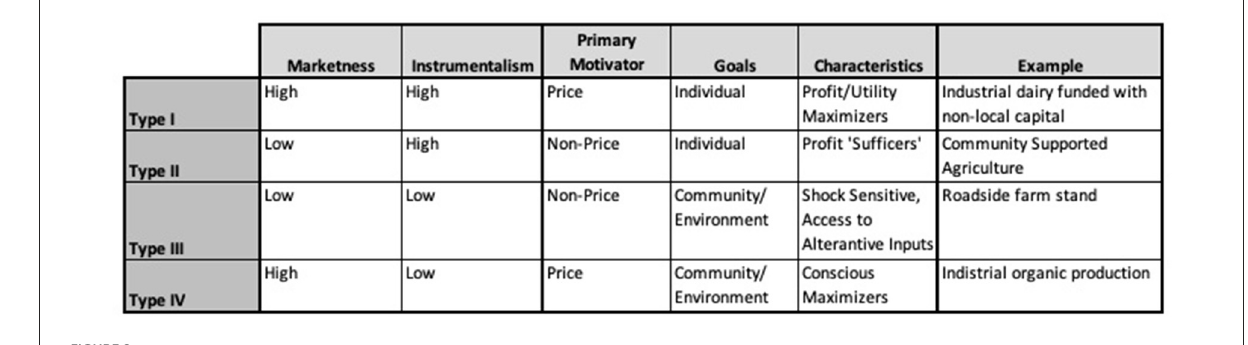
FIGURE2 Summary of embeddedness type